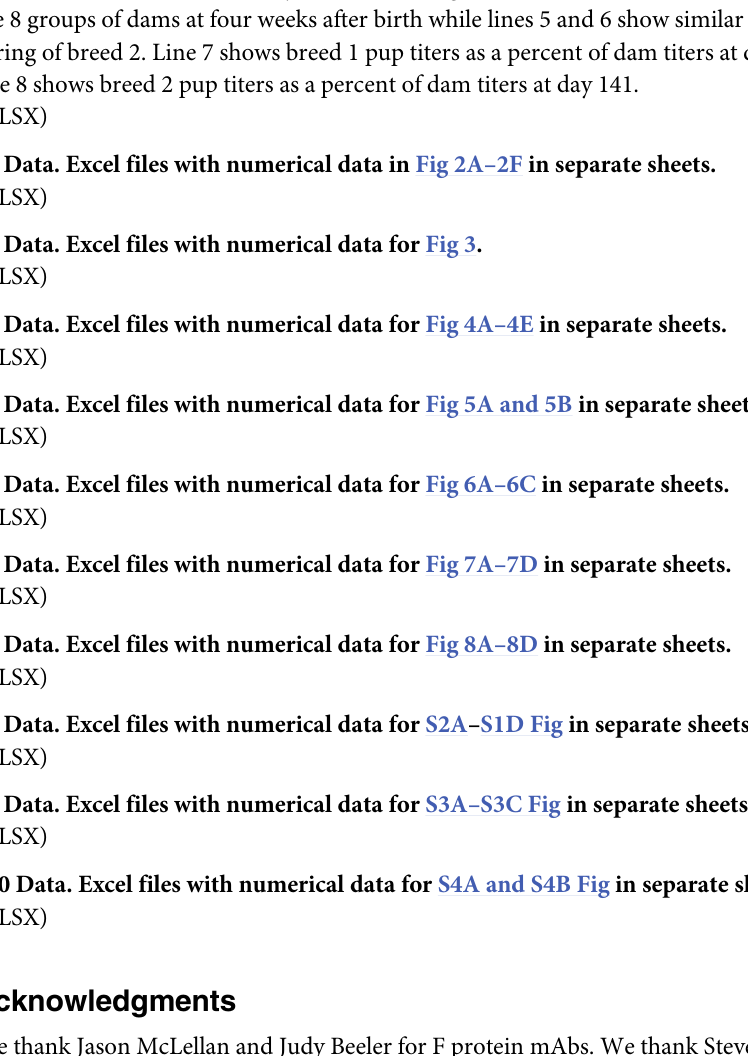
S3 Table. Comparisons of ng/ml of sera anti-pre-F IgG in dams and pups. The mean and standard deviations, respectively, of titers of anti-pre-F IgG, measured by ELISA, in each of the 8 groups of dams at day 141 is shown on the first two lines. Lines 3 and 4 show means and standard deviations, respectively, of anti-pre-F IgG titers in sera of breed 1 offspring of each of the 8 groups of dams at four weeks after birth while lines 5 and 6 show similar data for off- spring of breed 2. Line 7 shows breed 1 pup titers as a percent of dam titers at day 141 while line 8 shows breed 2 pup titers as a percent of dam titers at day 141.